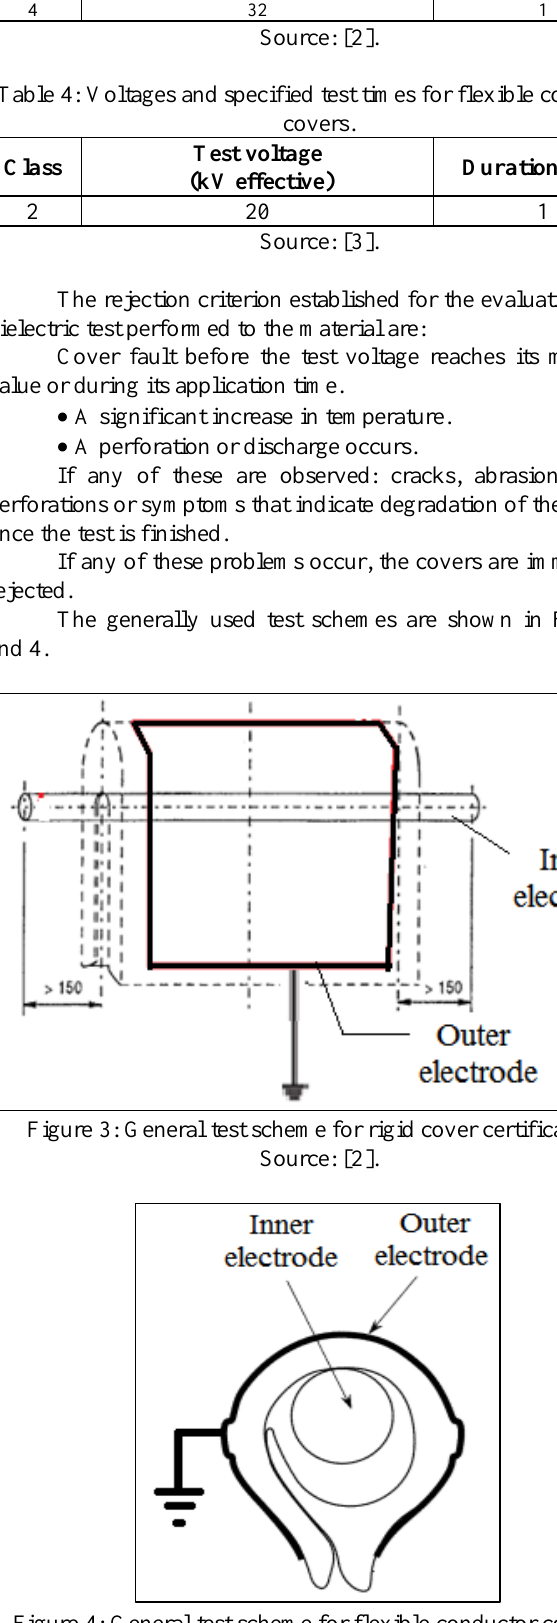
Figure 4: General test scheme for flexible conductor